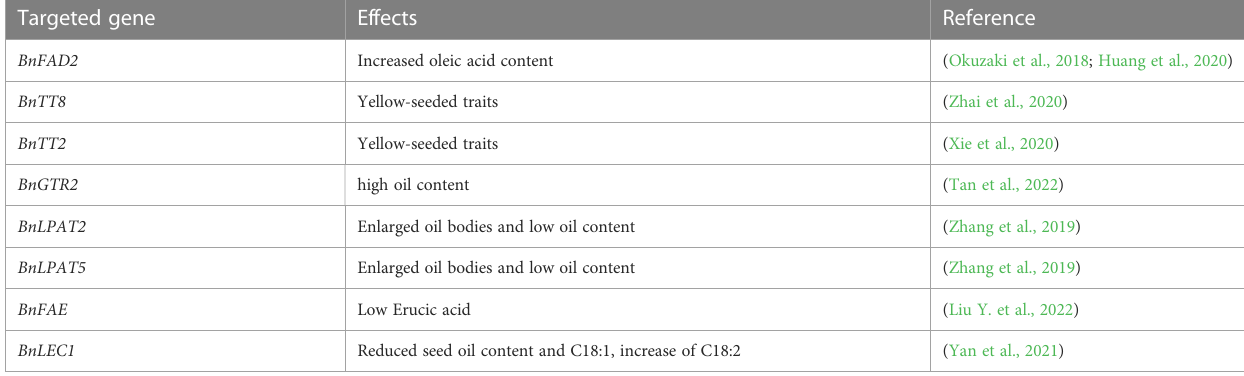
TABLE 1 The genes targeted for seed oil improvement in Brassica napus L. by CRISPR